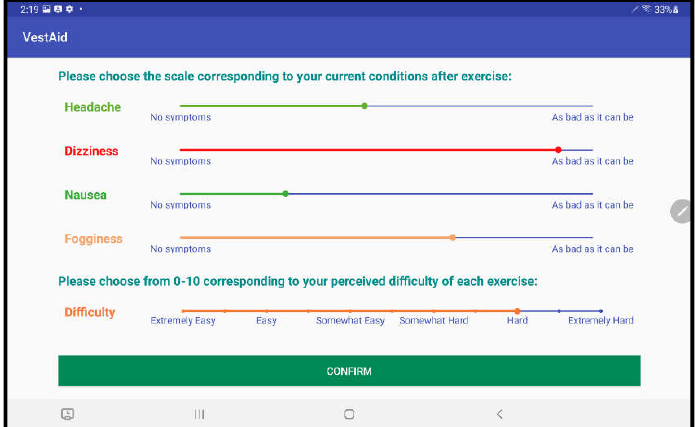
Figure 6. Post-exercise symptom rating page.